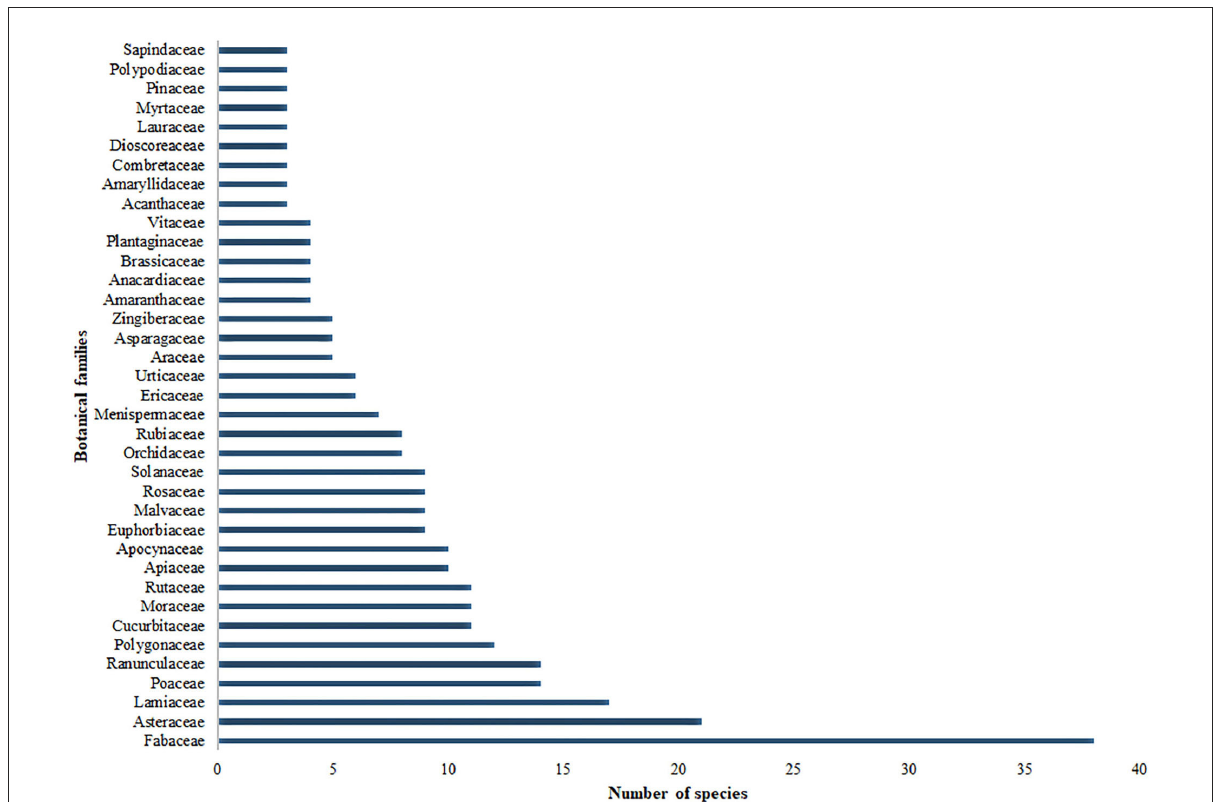
FIGURE1 Dominant families with respect to species (families having three or more species are